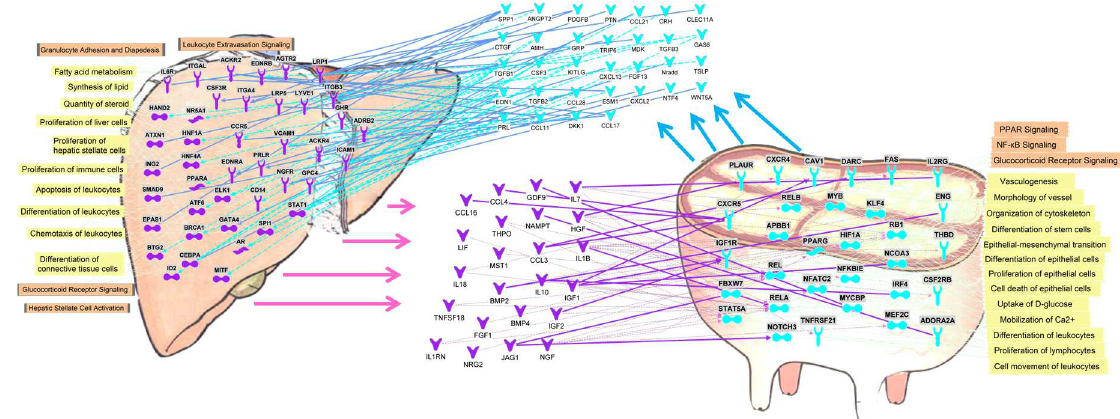
Fig 7. Potential crosstalkbetween liver (purple objects, arrows, and lines) and mammary tissue (blue objects, arrows, and lines) obtained by in silico approach via Ingenuity Pathway Analysis. Genes codingfor secreted proteins (i.e., cytokines, growth factors) with higherexpression( (cid:21) 2-fold; FDR < 0.001)in liver vs . mammary tissue have the potential to interact with receptors more expressed( (cid:21) 2-fold; FDR < 0.001)in mammary tissue vs . liver and vice versa . The most significantfunctions (yellowshade)and pathways (orangeshade) associated with the receptors are